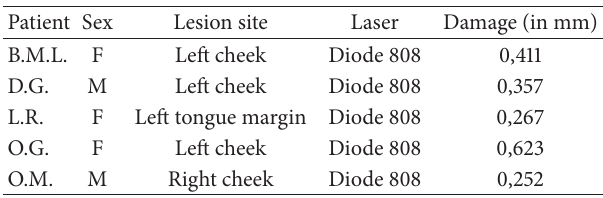
Table 2: Fibroma biopsies.